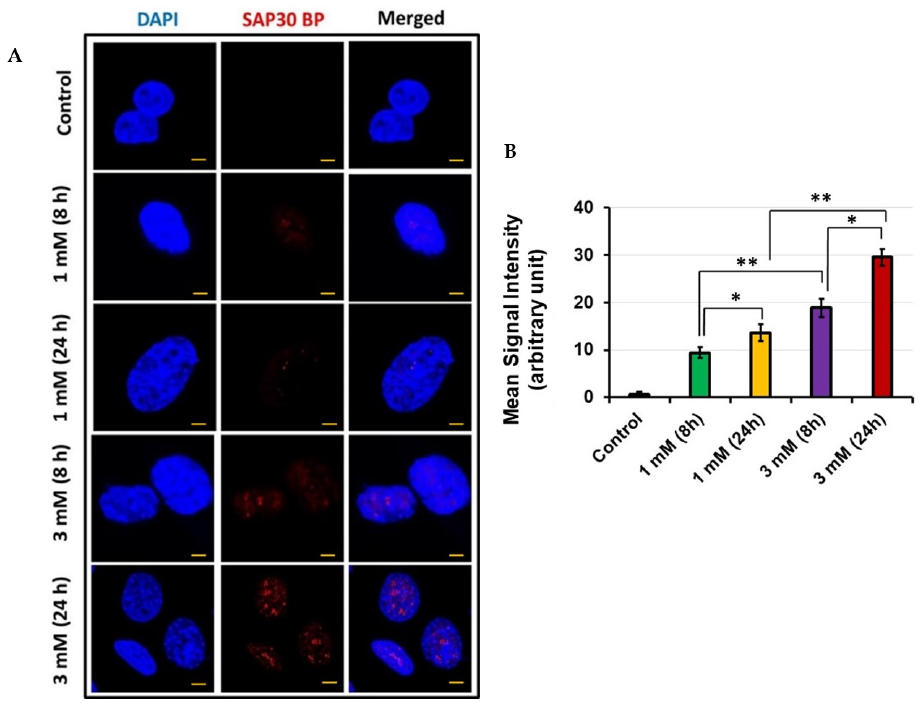
Figure 3. Sap30bp immunostaining: ( A ) representative photomicrographs showing Sap30bp expres- sion in HEI-OC1 cells treated with gentamicin. Red: Sap30bp; Blue: cell nuclei. Scale Bars: 20 µM; ( B ) ImageJ software was used to determine mean signal intensity for Sap30bp. * p < 0.05 or ** p < 0.01.